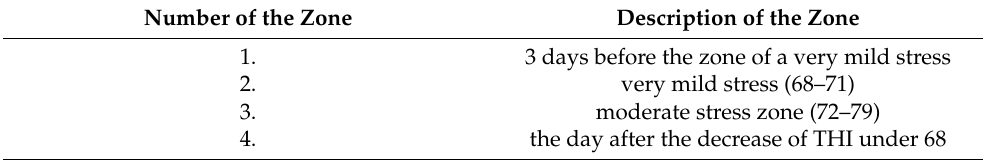
Table 3. Zones of